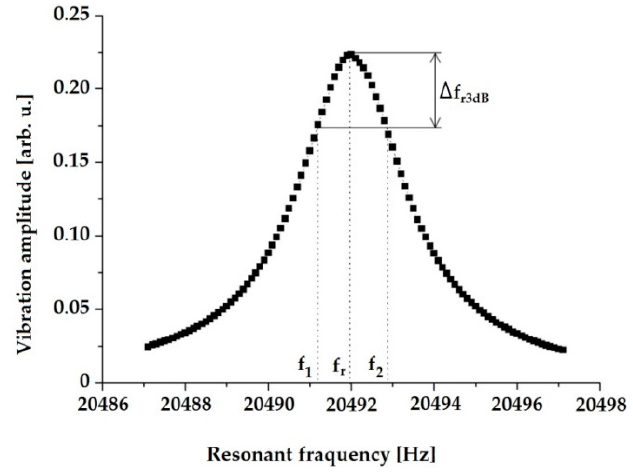
Figure 7. Schematic drawn of the resonant curve and estimation of the limiting frequencies f 1 and f 2 .